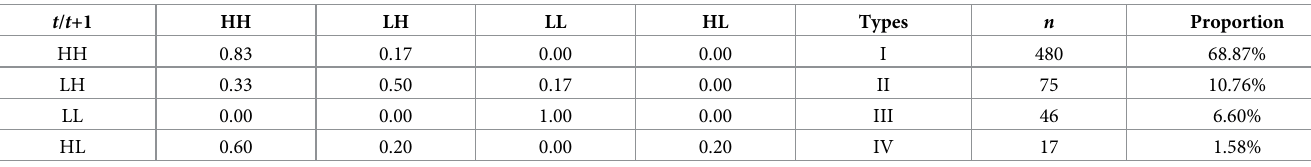
Table 5. Transition probability matrices of local Moran 0 s